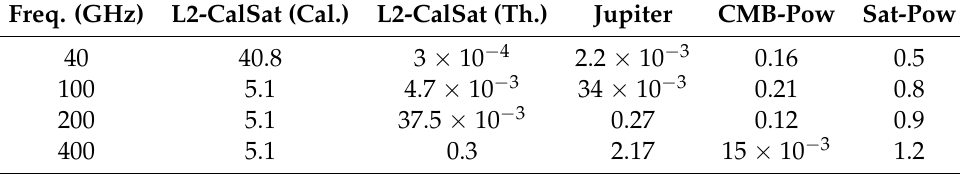
Table 3. Power arriving from Jupiter and L2-CalSat to a focal plane with 0.3 m aperture diameter. The maximum power of the calibration signal (second column), the thermal power from L2-CalSat (third column) and the thermal power from Jupiter (fourth column) are shown. Additionally, the power from CMB and the detectors saturation power are shown in the last two columns. All power values are given in pW. A Jupiter temperature of 160 K, fractional bandwidths of 0.25, Jupiter-Earth distance of 4.2 A.U. and distance between spacecrafts of 6600 m, have been considered in the calculations. Freq. (GHz)